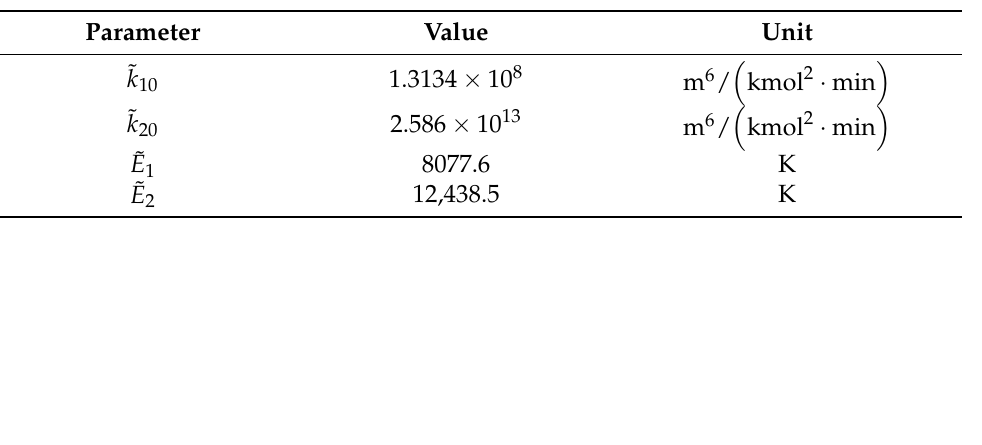
Table 2. Williams–Otto reactor: Model